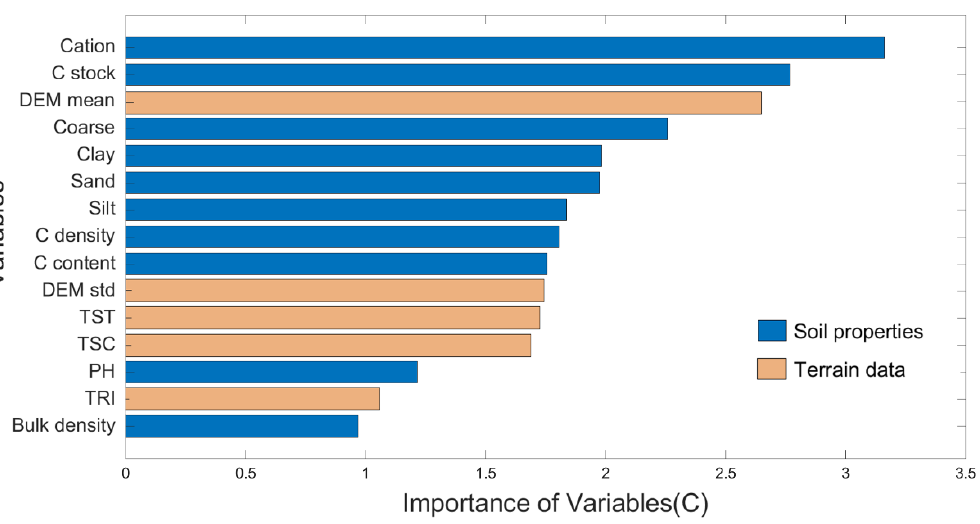
Figure 4. Feature importance of the selected variables in the RF model for predicting the 𝐶 values in 2018.